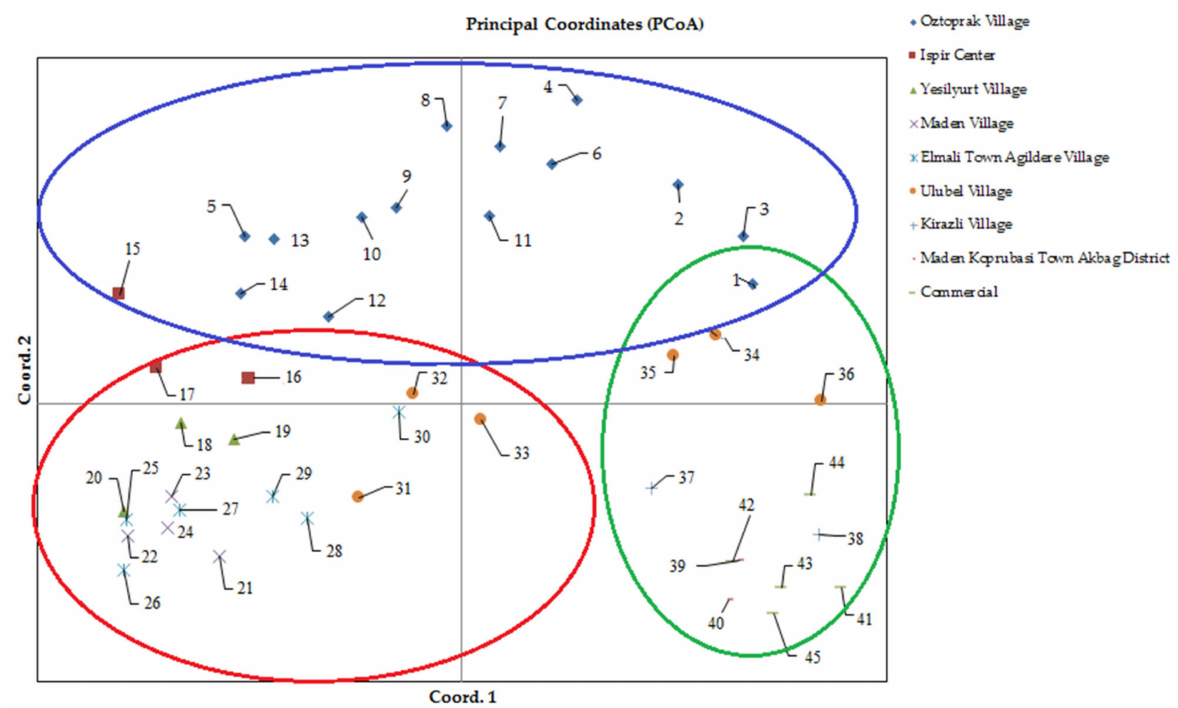
Figure 3. Principal coordinate analysis using SSR primer and separation on a two-dimensional diagram. The numbers in this figure represent the code numbers of the bean accessions presented in Table